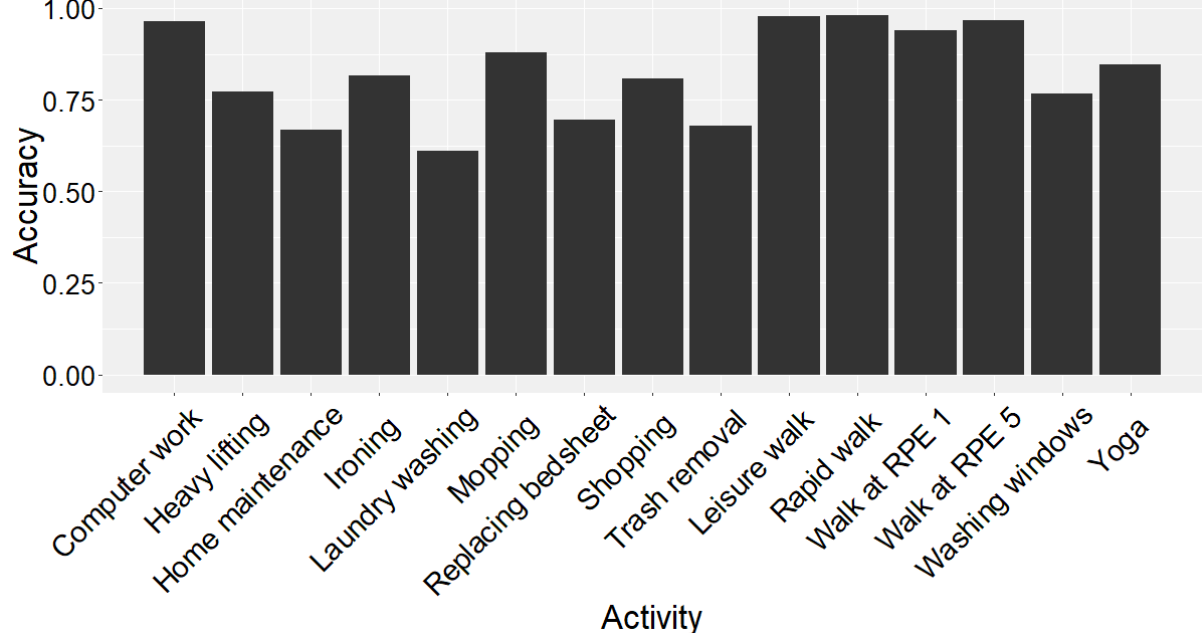
Figure 10. Balanced accuracy for each activity using the random forest model and 16-seconds window for extraction of features. RPE: ratings of perceived exertion.